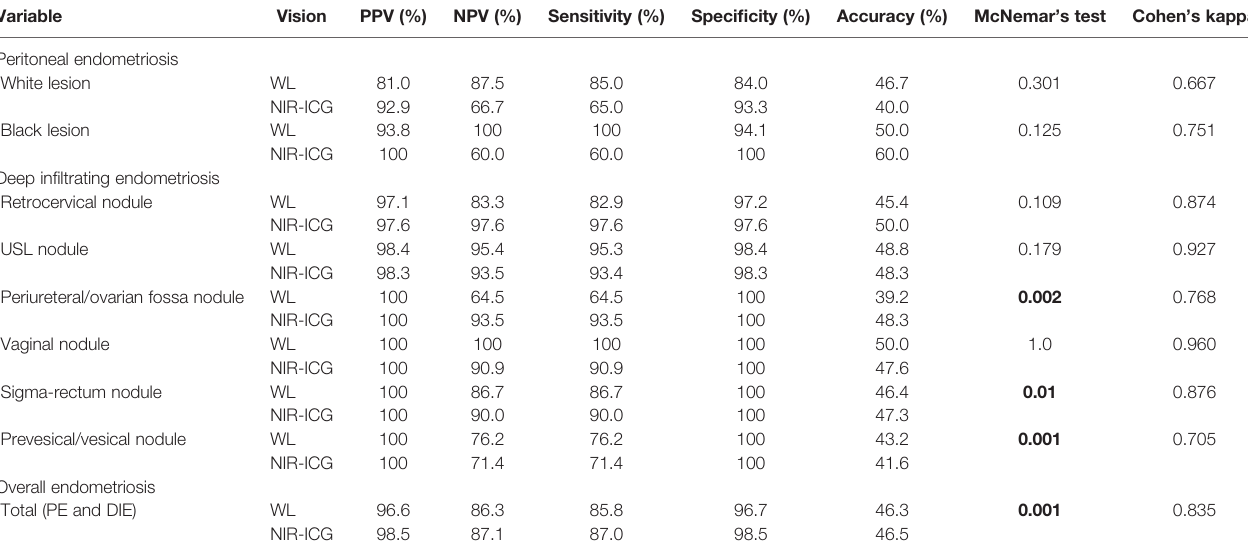
TABLE 5 | Comparison between the NIR-ICG and WL for each surgical site in the whole population. Variable